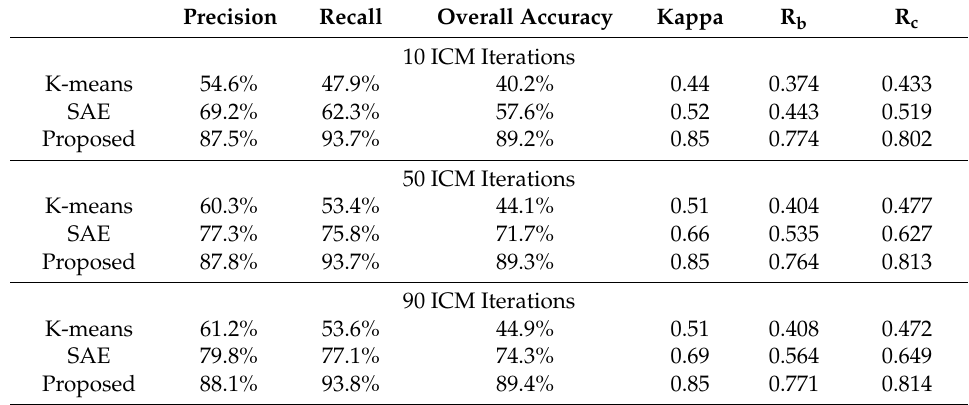
Table 3. Analysis of different methods for Markov label field initialization with different iterations. Precision Recall Overall Accuracy Kappa R b R c